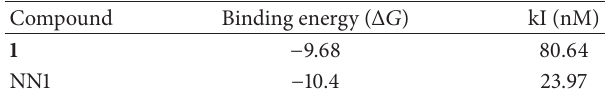
Table 1: Binding energy and kI for compounds 1 and NN1 toward the 11 𝛽 -HSD1 active site calculated from the docking